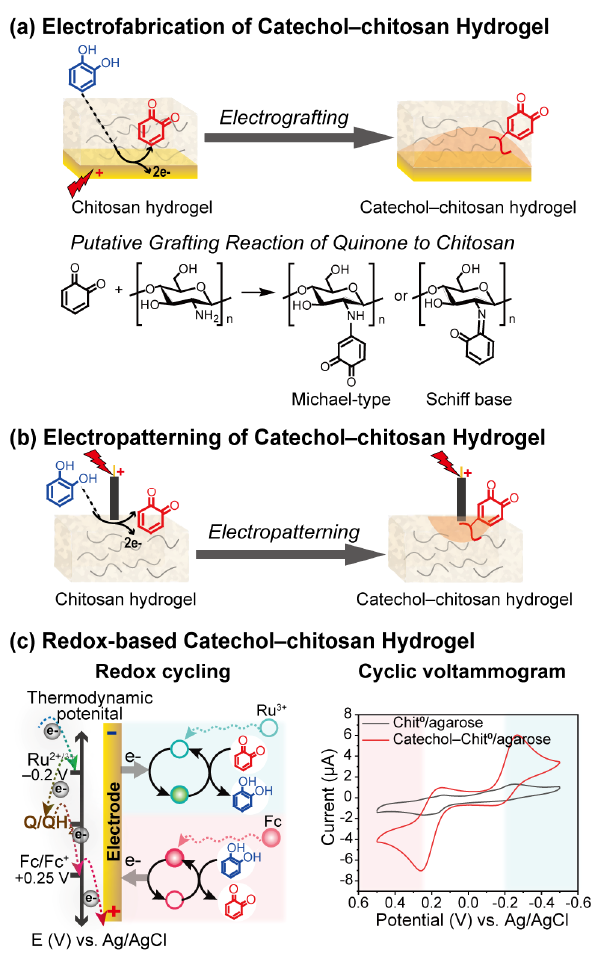
Figure 4. Redox-based hydrogels. ( a ) Electrofabrication of catechol–chitosan hydrogel. ( b ) Electropatterning of catechol–chitosan hydrogel. ( c ) The redox cycling and cyclic voltammogram of redox-based catechol–chitosan hydrogel. Adapted with permission from ref. [30]. Copyright (2019) ACS publications.